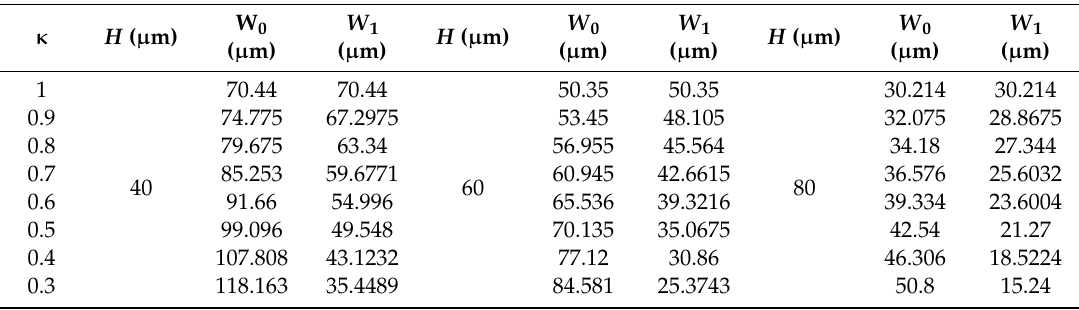
Table 2. Cross-sectional dimensions of the Y-shaped rectangular microchannels with adjusted widths ratio.